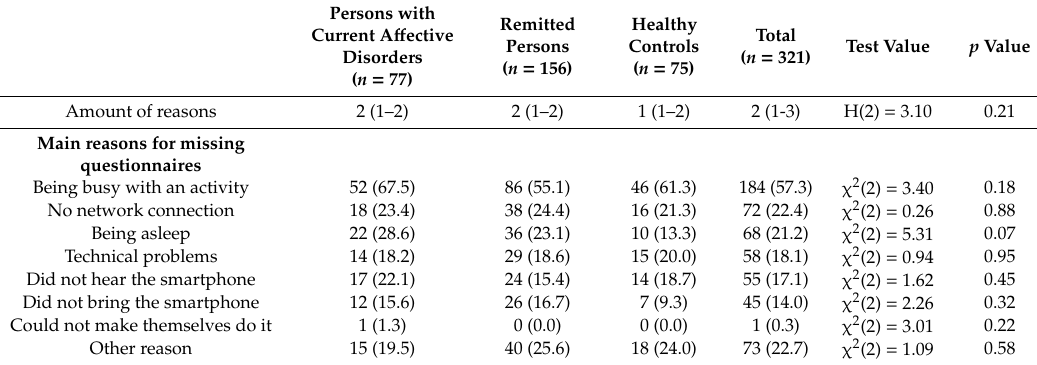
Table 3. Self-reported main reasons for missing EMA